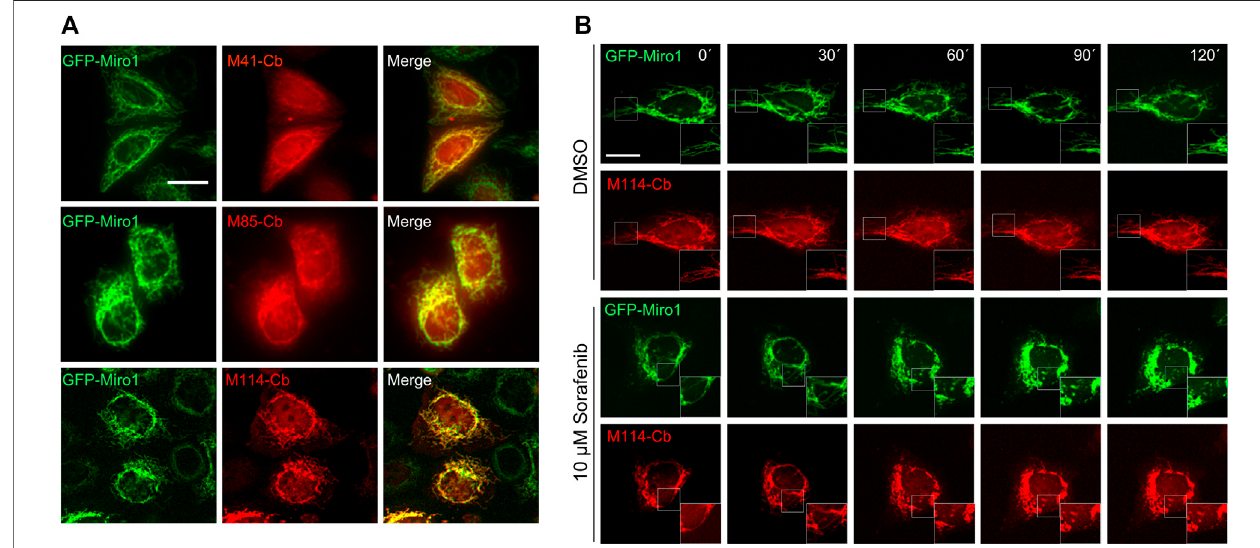
FIGURE 6 | Live-cell imaging of Miro1 with selected Miro1-Cbs. (A) Representative fl uorescence images of living HeLa cells transiently expressing GFP-Miro1 (left column) in combination with red fl uorescently labelled (TagRFP) M41-, M85- or M114-Cb (middle column). Scale bars 20 µm. (B) Time-lapse microscopy of U2OS cells transiently expressing GFP-Miro1 in combination with either M114-Cb or mito-Mkate2. To visually track morphological mitochondrial changes, cells were treated with eitherDMSOasacontrol(toptworows)or10 µMSorafenib(bottomtworows)followedbytime-lapseimagingovera2 hperiod.Shownarerepresentativeimages of three biological replicates. Scale bar 25 µm. Squares at the bottom right represent enlargements of the selected image